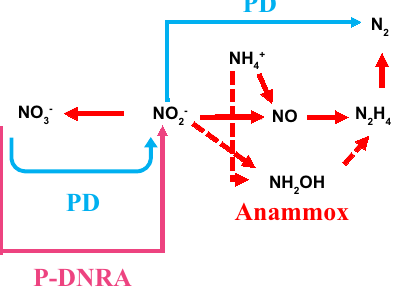
Fig. 8 Illustration of synergistic relationship of anammox-DNRA- PD (SPDAD). Blue arrows showed the PD process, red arrows showed anammox reaction, and pink arrows showed the partial- DNRA